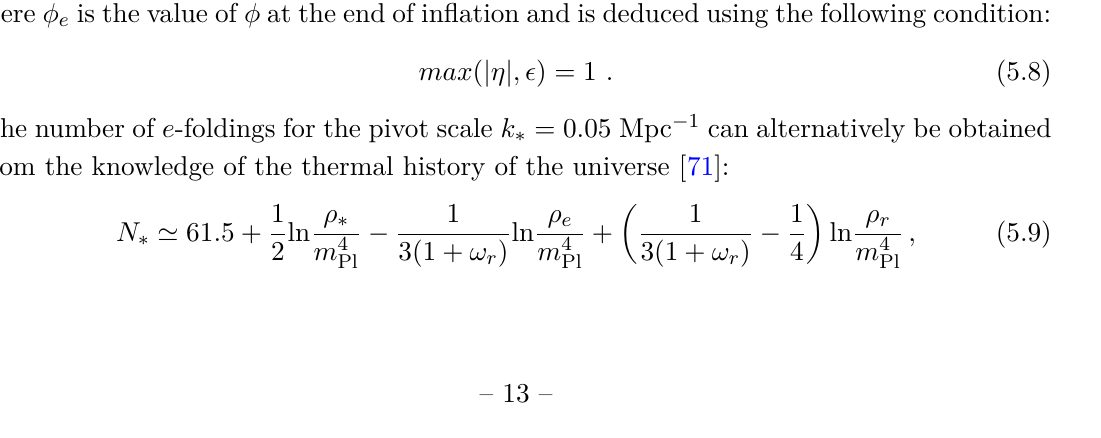
JHEP02(2021)114 . p at M . For this fit, g [0 . 51 , 0 . 56] II U ∈